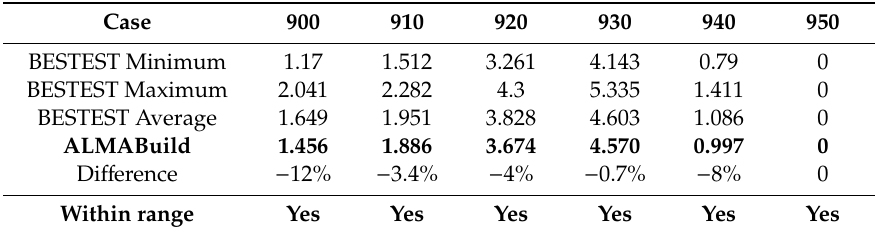
Table 5. Annual Heating Load (MWh) obtained for non-free-float heavyweight BESTEST cases compared with the minimum and maximum threshold values indicated by BESTEST.